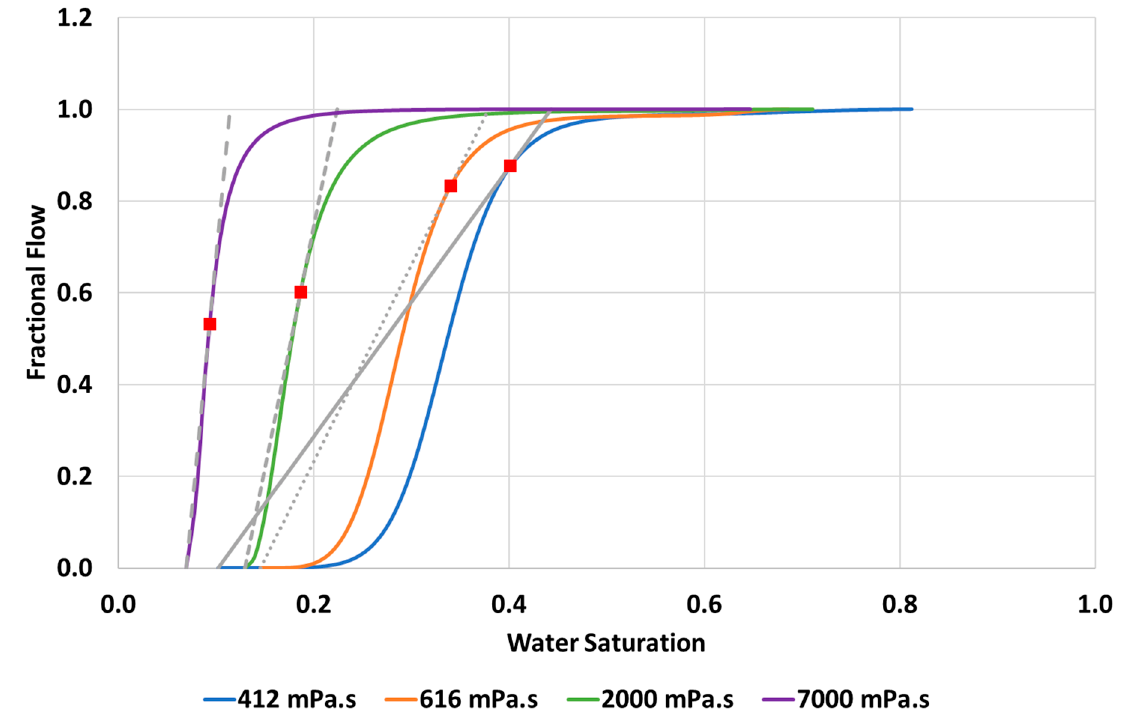
Figure 16. Finger patterns for displacement of 412 mPa.s, 616 mPa.s, 2000 mPa.s and 7000 mPa.s oil